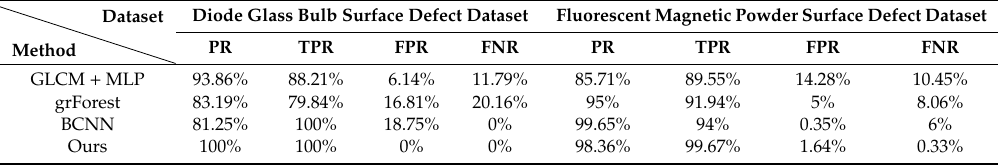
Table 5. Results of the four methods PR, TPR, FPR and FNR on the diode glass bulb and fluorescent magnetic powder surface defect